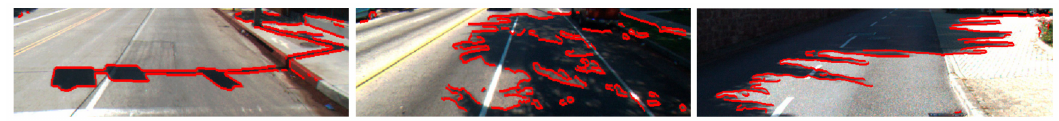
Figure 13. Shadow edge detection results of images in Figure 12 obtained by Property 1.